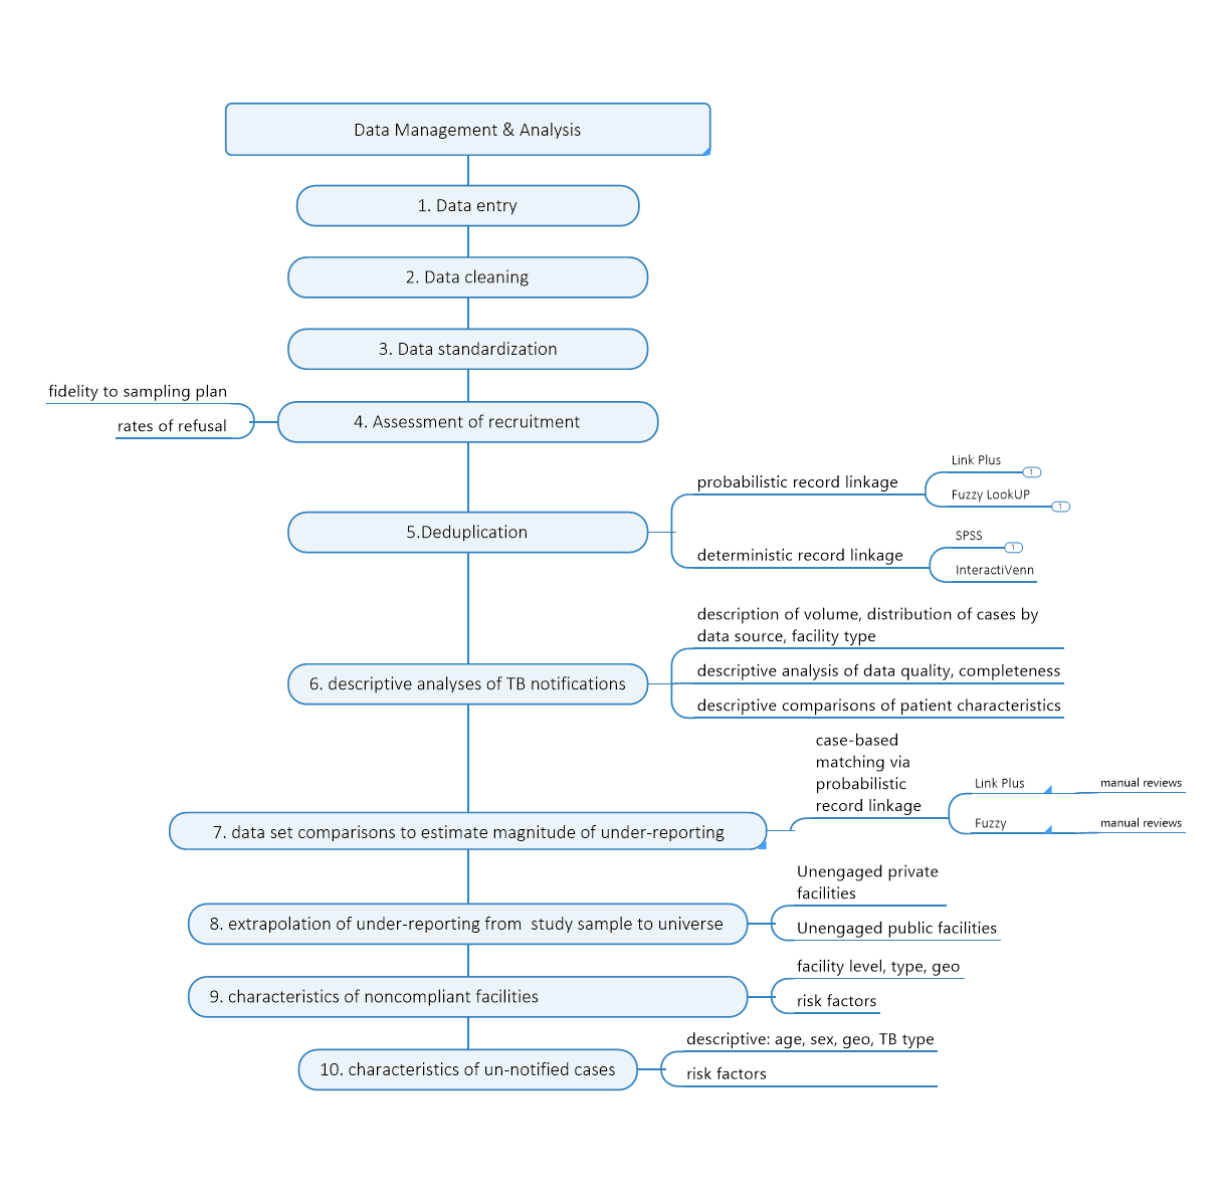
Figure 4. Overview of the sequence of data management and analysis steps. TB: